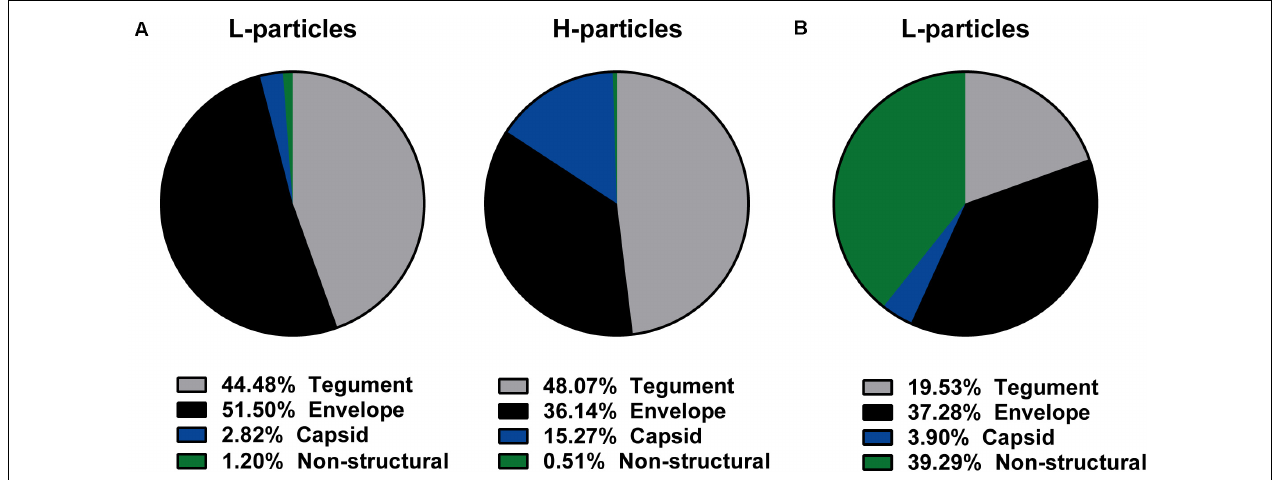
FIGURE 2 | Viral protein distribution of HSV-1-derived particles isolated from infected BHK21 cells or mDCs. (A,B) L-particles and H-particles were purified from supernatants of HSV–1-infected BHK21 cells (A) and mDCs (B) four days post infection and 20 hpi, respectively. Protein distribution of L- and H-particles was analyzed by mass spectrometry. The total intensity of viral proteins was set to 100% and relative values (normalized to the mean of all present glycoproteins) for H- and L-particle samples are shown regarding their predicted protein localization. The data are based on four BHK21cell- or three mDC-derived particle